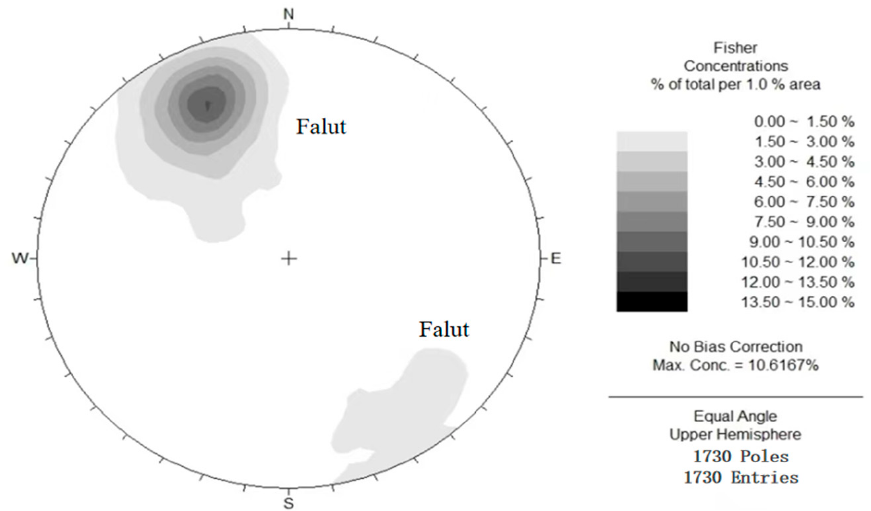
Figure 5. Iso-density map of fault poles in the dam site area.